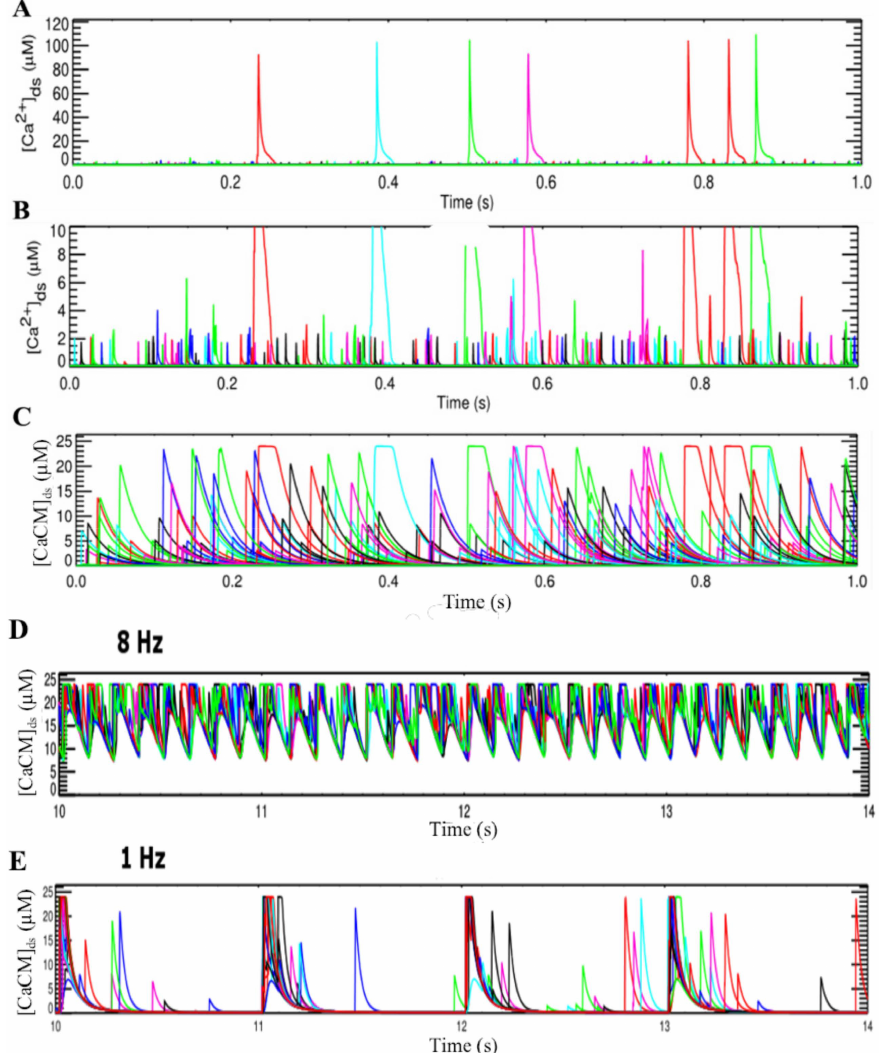
Figure A1. Calcium in the subspaces during ( A ) Ca 2+ sparks and ( B ) Ca 2+ quarks, ( C ) The amount of Ca 2+ : CaM complex in the subspace during spontaneous Ca 2+ sparks and quarks at rest. The amount of Ca 2+ : CaM complex in the subspace is greater during ( D ) pacing at 8 Hz compared to ( E ) pacing at 1 Hz pacing leading to increased Ca-dependent inactivation of the L-type